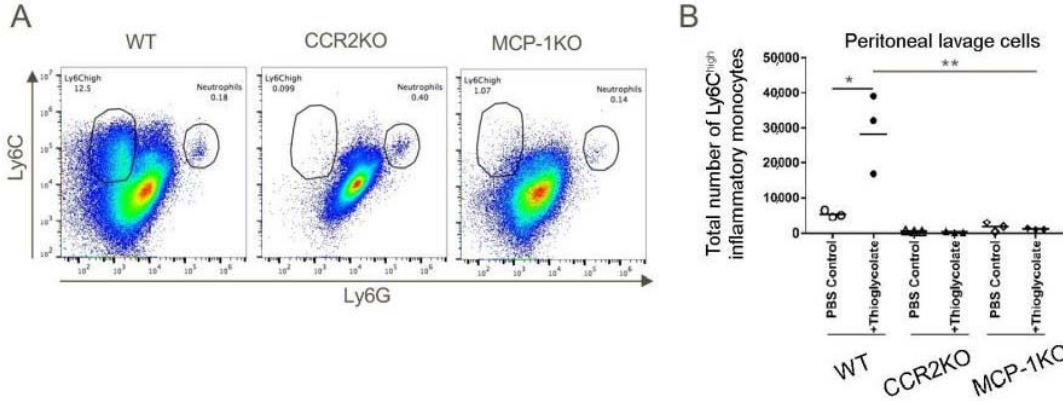
Figure 4. The MCP ‐ 1/CCR2 chemokine/chemokine receptor pathway axis has an indispensable role in the migration of CD11b+Ly6C high cells to sites of inflammation. WT, CCR2KO and MCP1KO mice were injected with thioglycolate broth and 48 h later peritoneal lavage cells were analyzed by flow cytometry. ( A , B ) CD11b+Ly6C high Ly6G low inflammatory monocytes failed to migrate in response to thioglycolate ‐ elicited inflammation in CCR2KO and MCP ‐ 1KO mice; * p < 0.05 and ** p < 0.01 ( n = 3/group). Data are representative of three independent experiments.